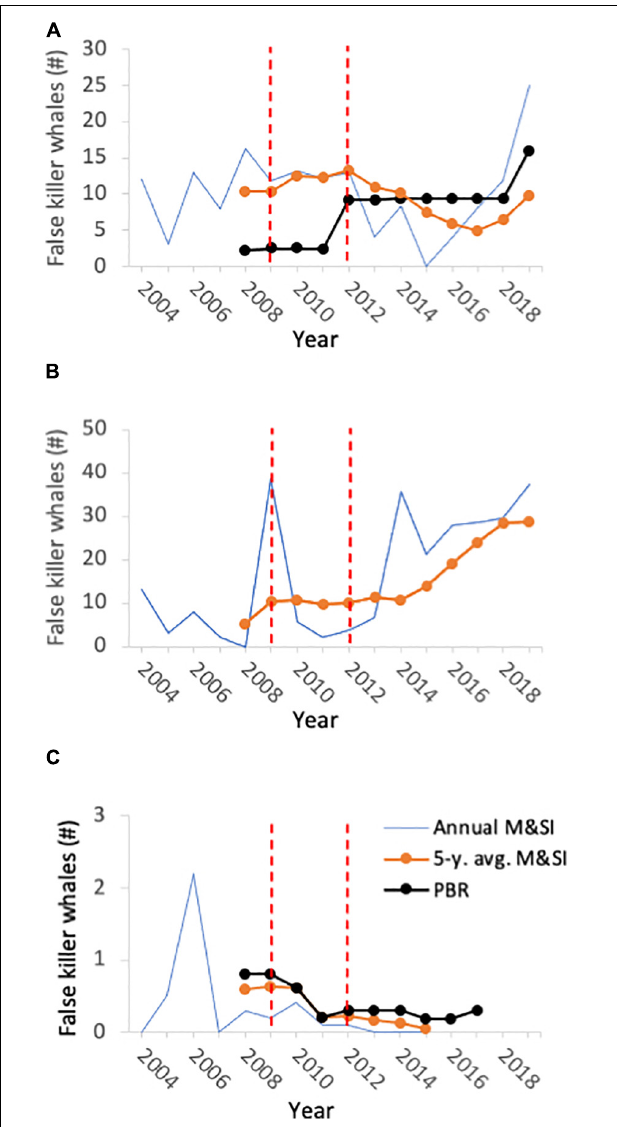
FIGURE 3 | Annual estimated mortality and serious injury (M&SI), 5 year moving average of M&SI, and potential biological removal (PBR) for three false killer whale stocks taken in the U.S Hawai‘i pelagic longline deep-set fishery: (A) pelagic stock inside of the U.S. EEZ; (B) pelagic stock outside of the U.S. EEZ (no PBR available); and (C) insular, main-Hawaiian Islands stock. The dashed red lines indicate the year of False Killer Whale Take Reduction Team establishment (left, 2009) and year of publication of the final regulatory rule implementing the False Killer Whale Take Reduction Plan (right,